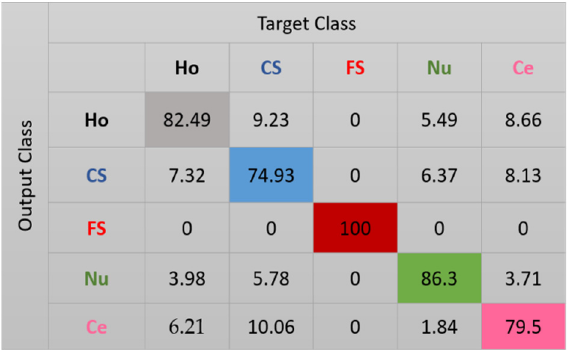
Figure 7. Confusion matrix for case-1. “Ho”, “CS”, “FS”, “Nu”, and “Ce” represent homogeneous, coarse speckled, fine speckled, nucleolar, and centromere cells, respectively.